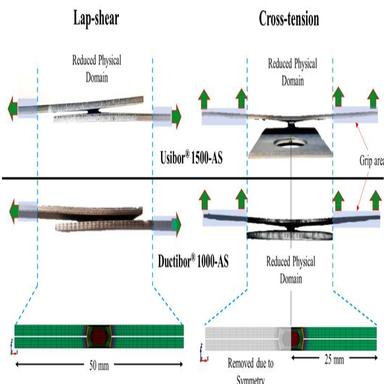
Correspondence between actual test specimen and the reduced physical domain for simulation.